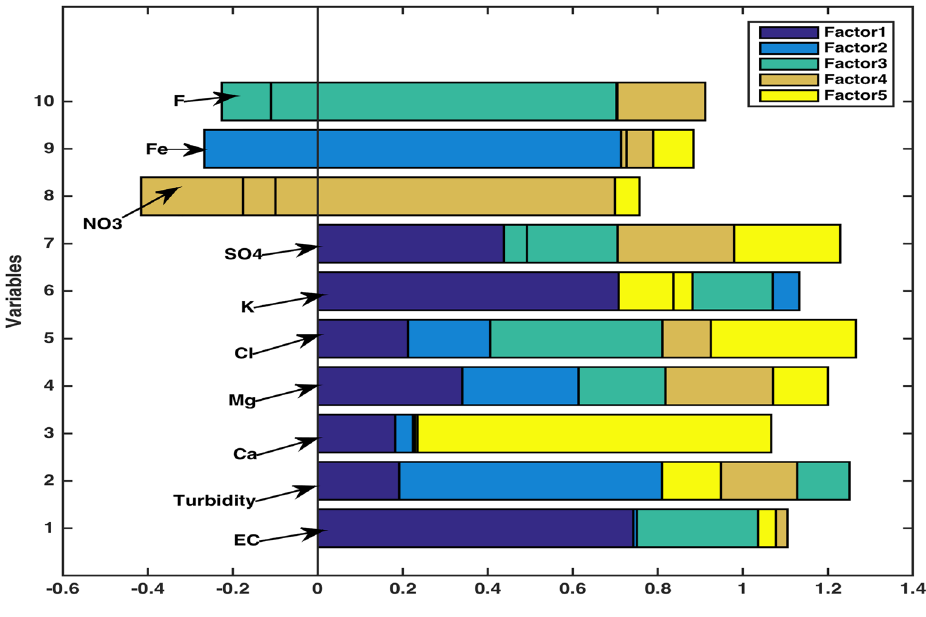
Figure 12. Rotated estimates of